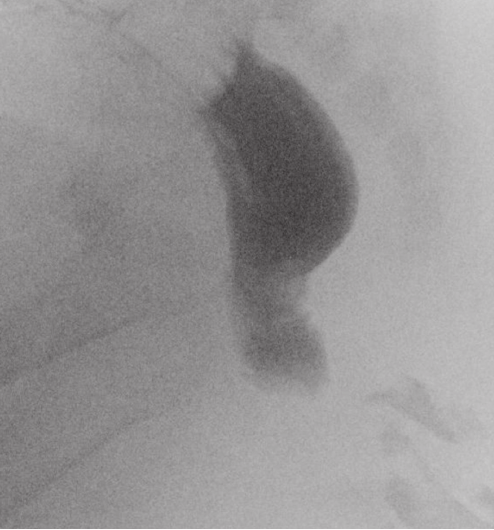
Figure 9: X-ray with contrast in the passive stoma. Before closure of the stoma, an open passage over the anastomosis was